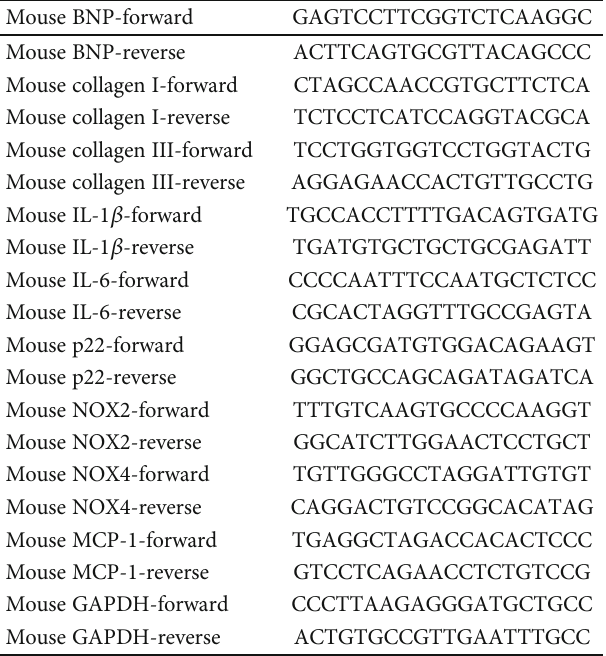
Table 1: Sequences of